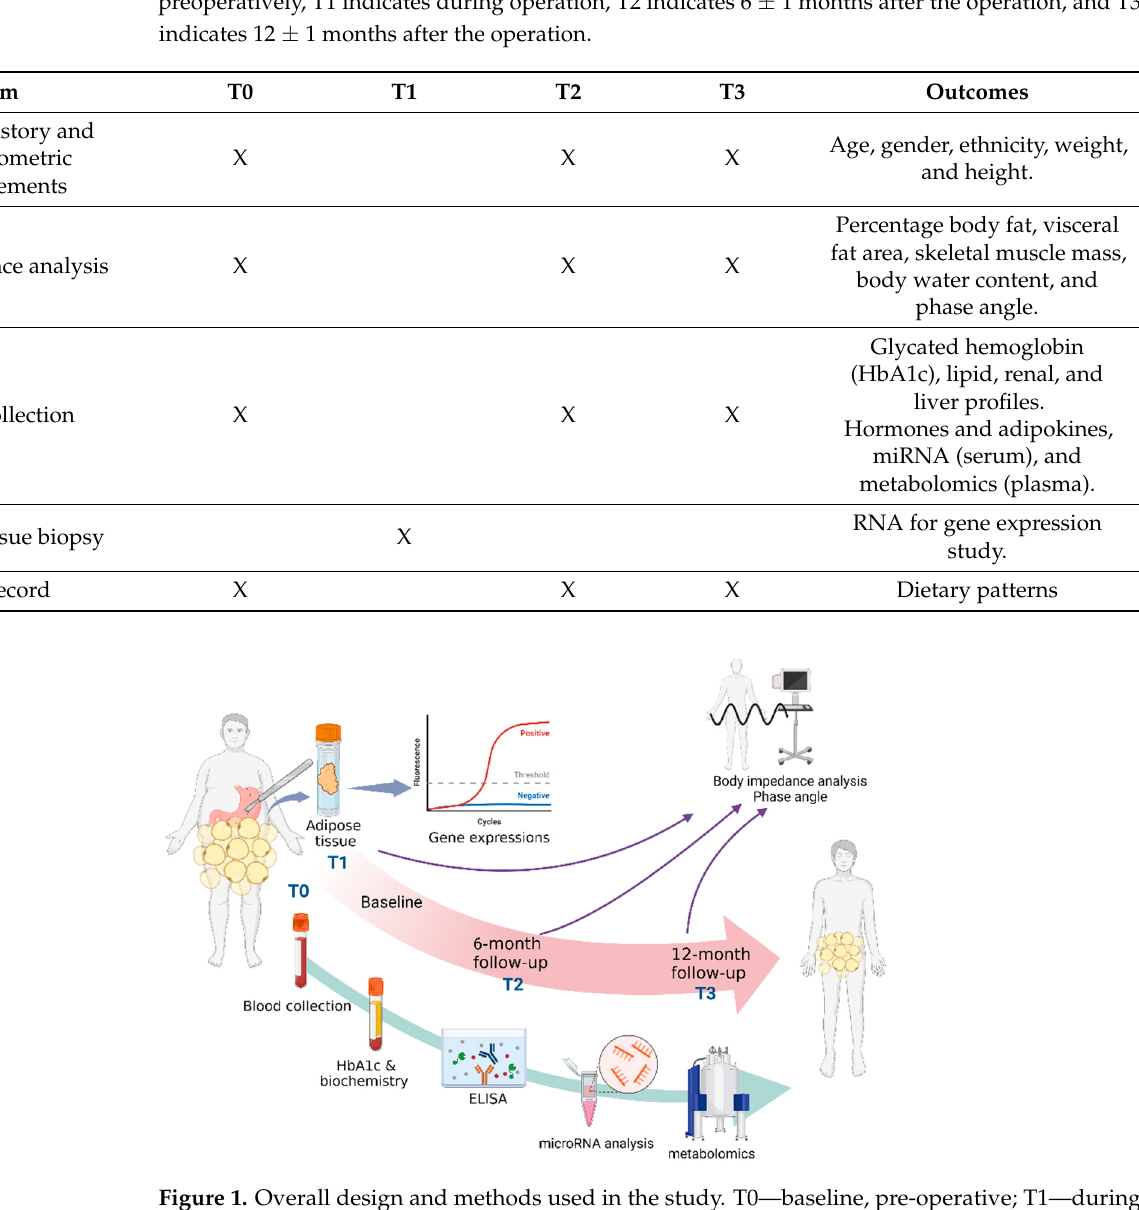
Table 1. The time points of sample collection and clinical and laboratory analyses. T0 indicates preoperatively, T1 indicates during operation, T2 indicates 6 ± 1 months after the operation, and T3 indicates 12 ± 1 months after the operation.